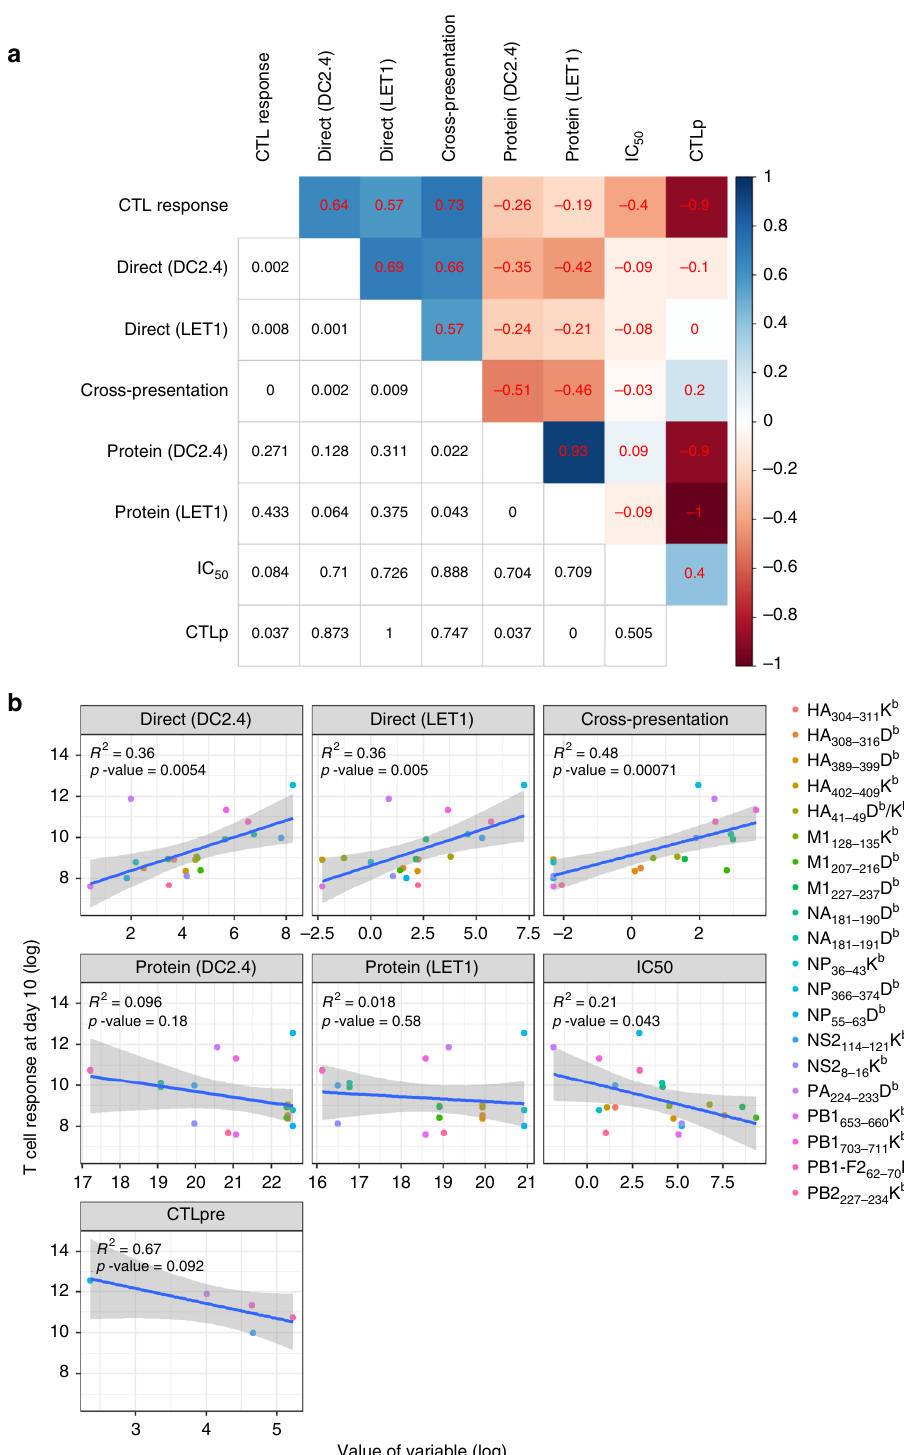
Fig. 6 Analysis of parameter contribution to CD8 + T-cell response hierarchy. a Correlations as assessed through spearman rank correlation test between all variables. Spearman rank correlation coef fi cient is shown in the upper diagonal and associated p value (not adjusted for multiple comparison) in the lower diagonal. Color coding indicates strength of positive (blue) or negative (red) correlation between speci fi c variables. Note that because the contribution of HA 41 – 49 bound to H-2D b or H-2K b could not be distinguished for CTL response, the abundance of HA 41 – 49 bound to H-2D b and H-2K b have been added for each of the presentation modalities to yield a single value. b Linear correlations between log-transformed outcome (CTL response magnitude at day 10) and log-transformed predictor variables. For each variable, we took the mean of all measurements before log transformation. R 2 values are shown for the performance of the model on the actual data used to fi t the model. CTLp frequencies for fi ve epitopes taken from ref.